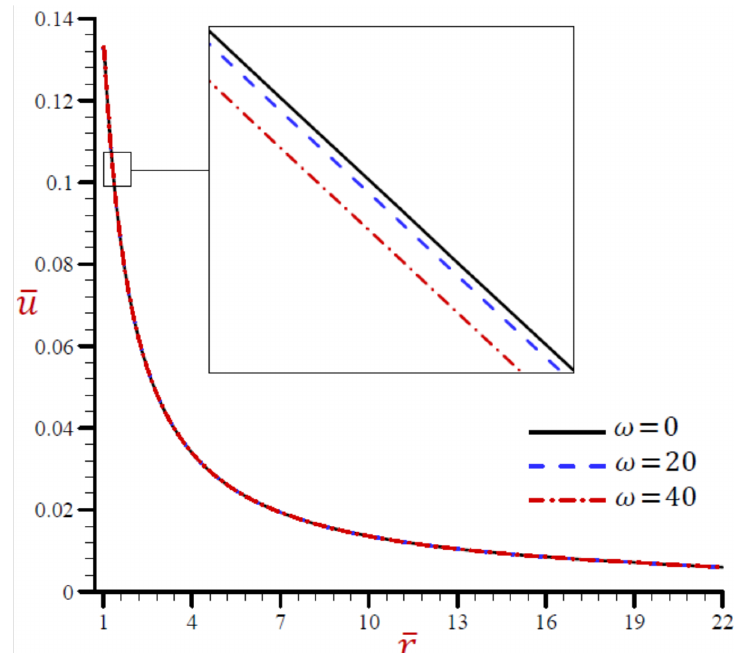
Figure 9. Effect of ω on radial displacement u across the radial direction of the cylindrical cavity utilizing the RDPL